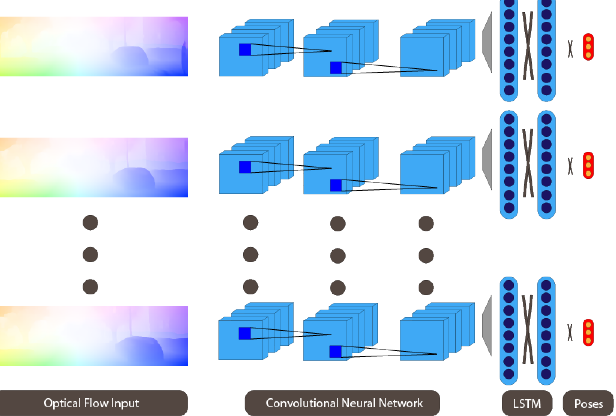
Figure 1. Overview of our approach: Optical flow is passed on to CNNs, extracting relevant features, which are in turn passed on to the